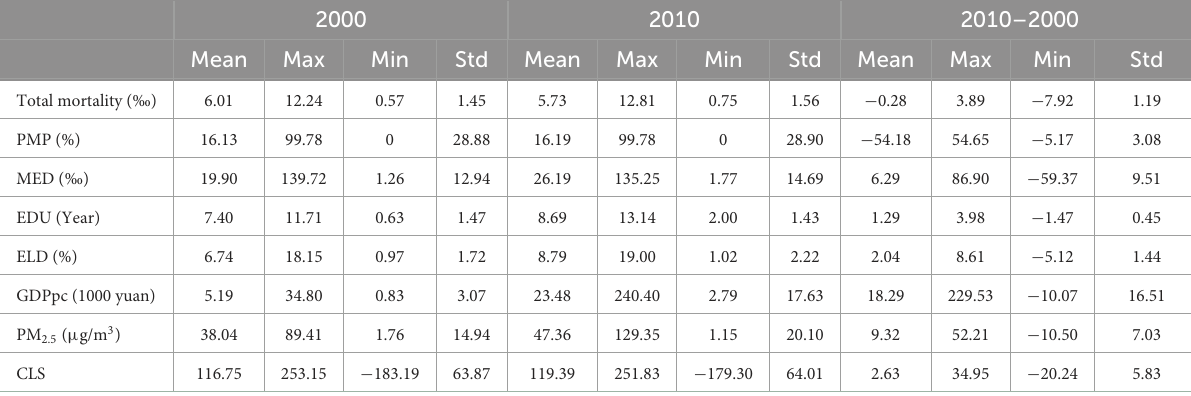
TABLE 1 Variable definitions and summary